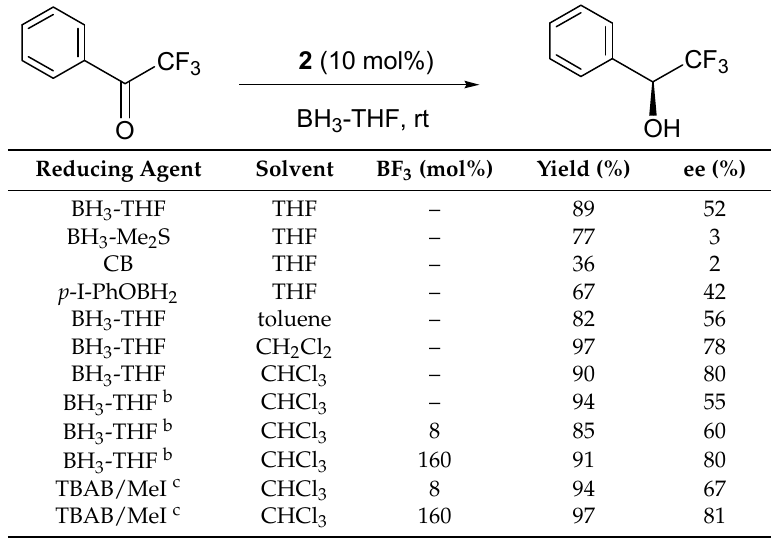
Table 3. Asymmetric reduction of 2,2,2-trifluoroacetophenone using lactam alcohol 2 a .